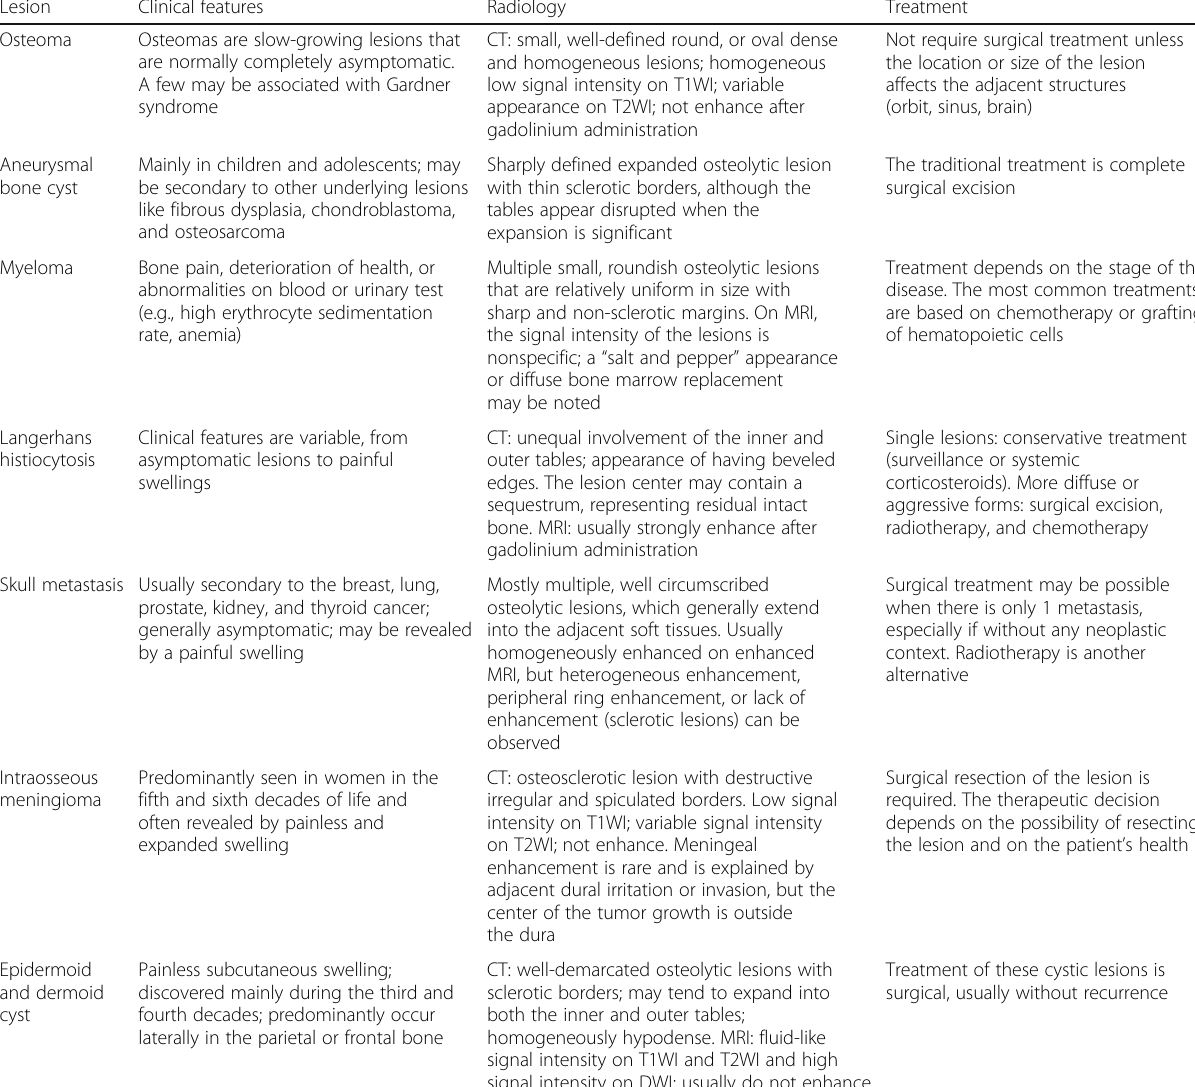
Table 2 Differential diagnosis of skull vault lesions